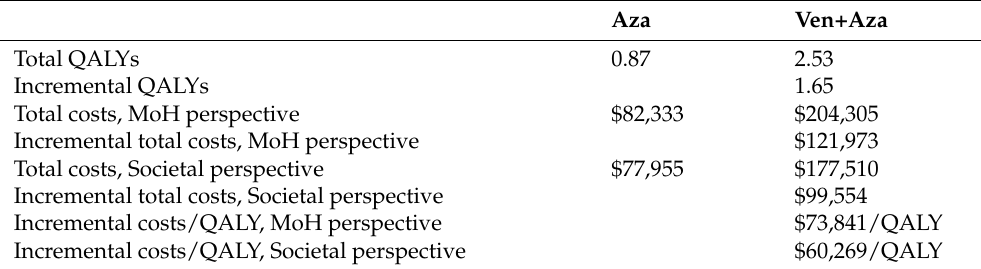
Table 3. Cost–utility